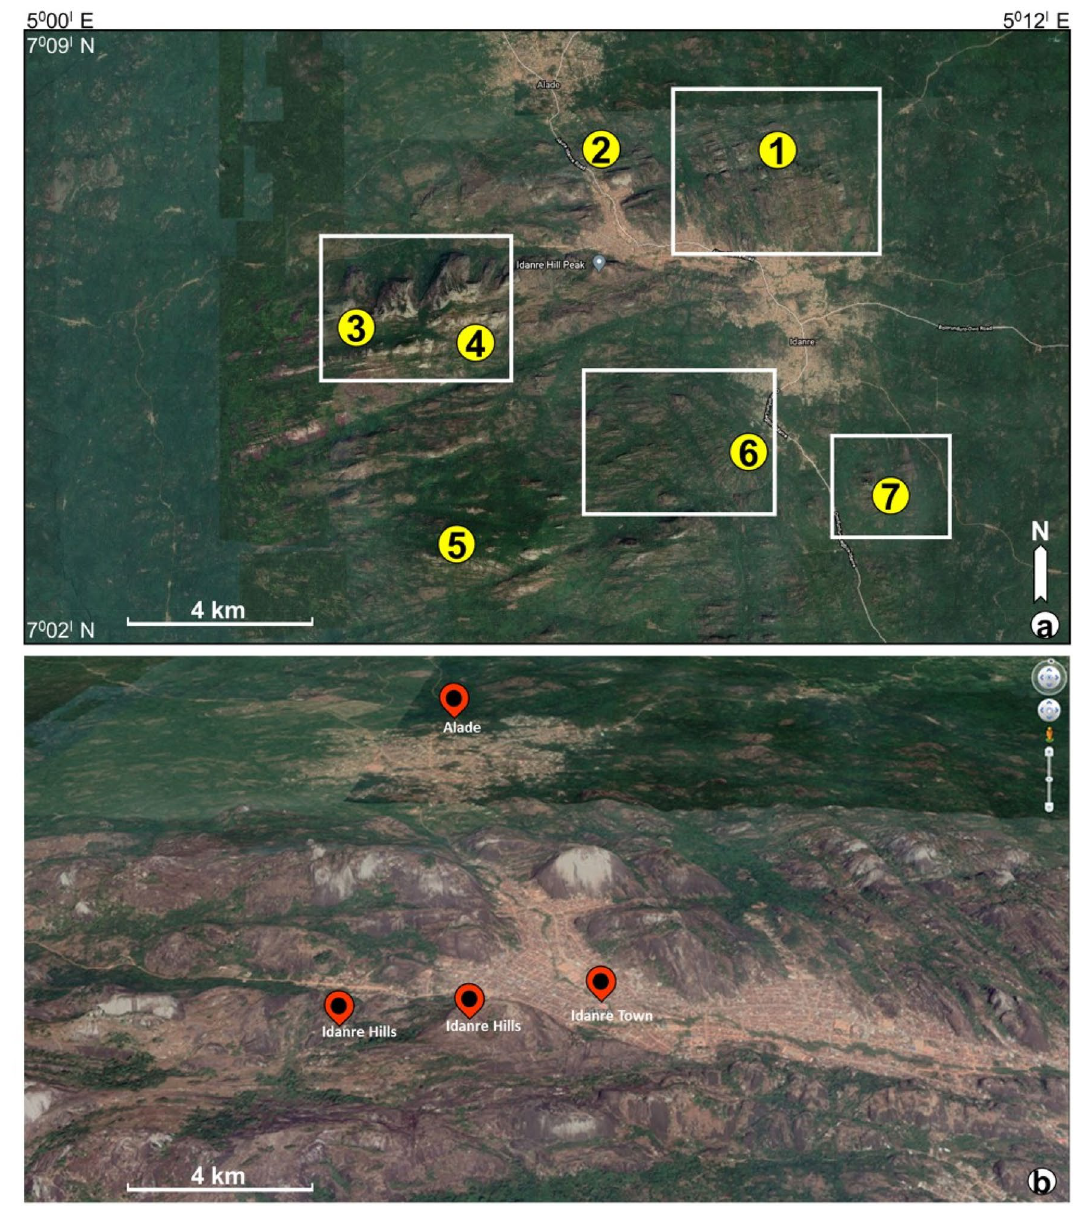
Figure 2. ( a ) Location map of the study as downloaded from google earth. Points marked as 1–7 highlight areas with interesting geological features and structures. ( b ) 3D view through the Idanre Hill and surrounding structural features. Images/Maps data: Google Earth, Maxar Technologies and